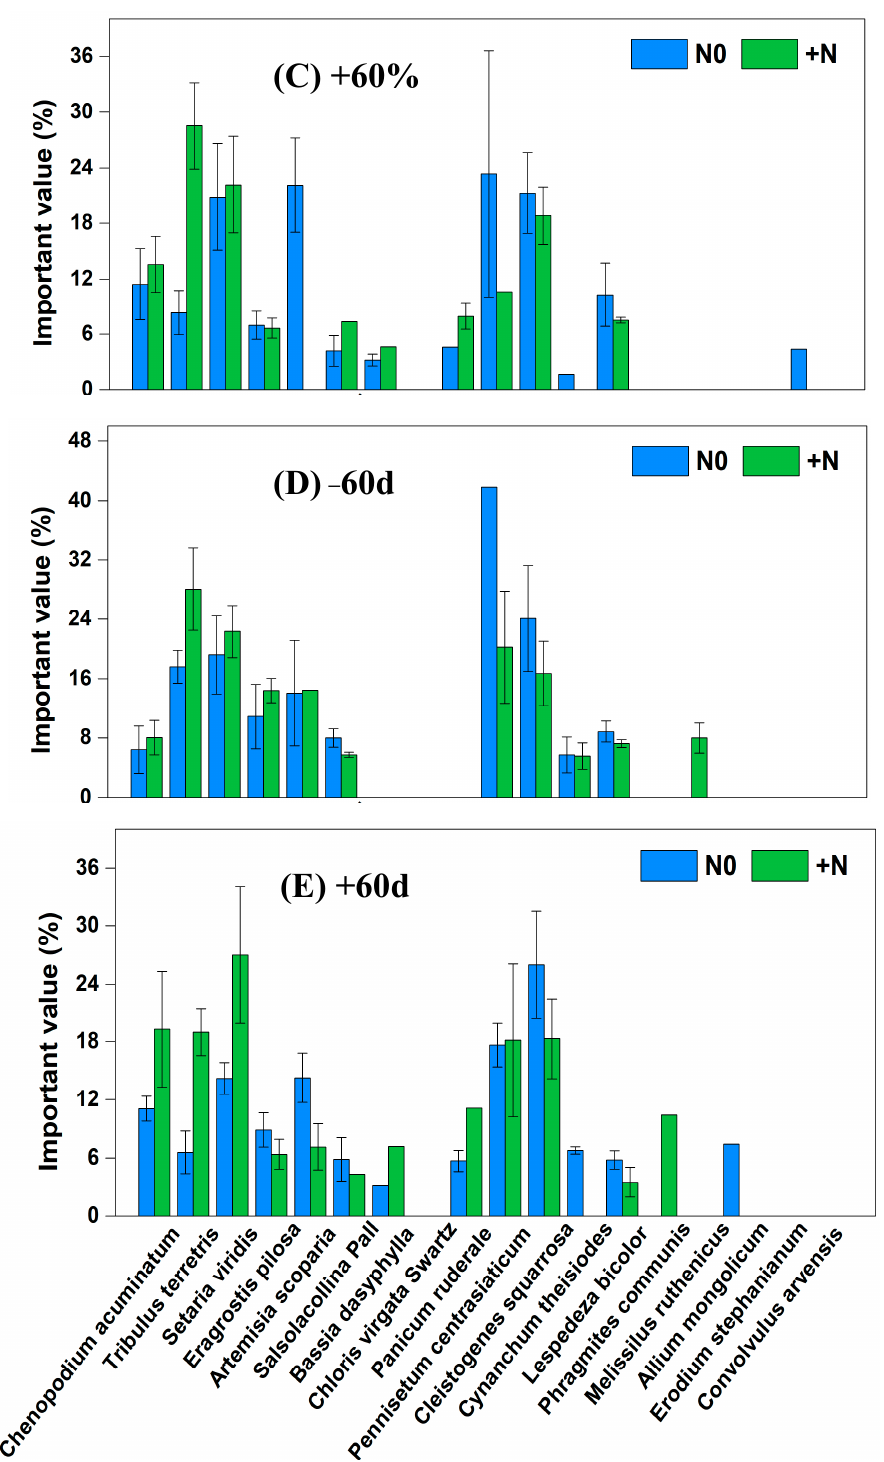
Figure 5. Changes of important values of vegetation in the sandy grassland under rainfall changes and nitrogen addition under grazing.